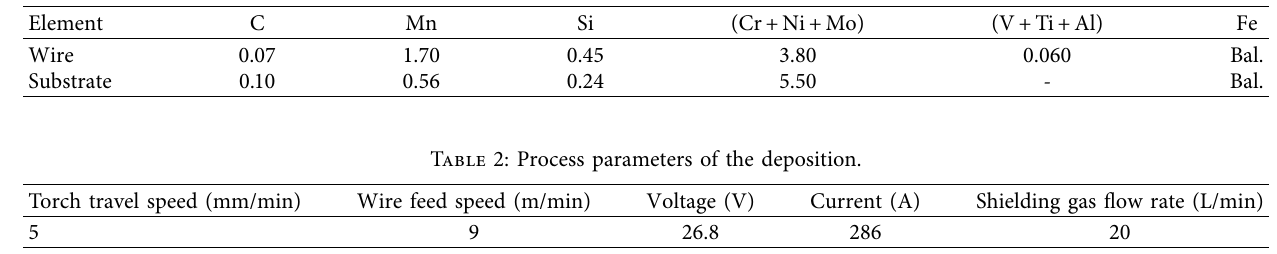
Figure 1: The WAAM system and manufacturing of the deposit. (a) The WAAM system; schematic illustrations of the (b) deposit and (c) deposition strategy. Table 1: Compositions of the wire and substrate (wt.%).